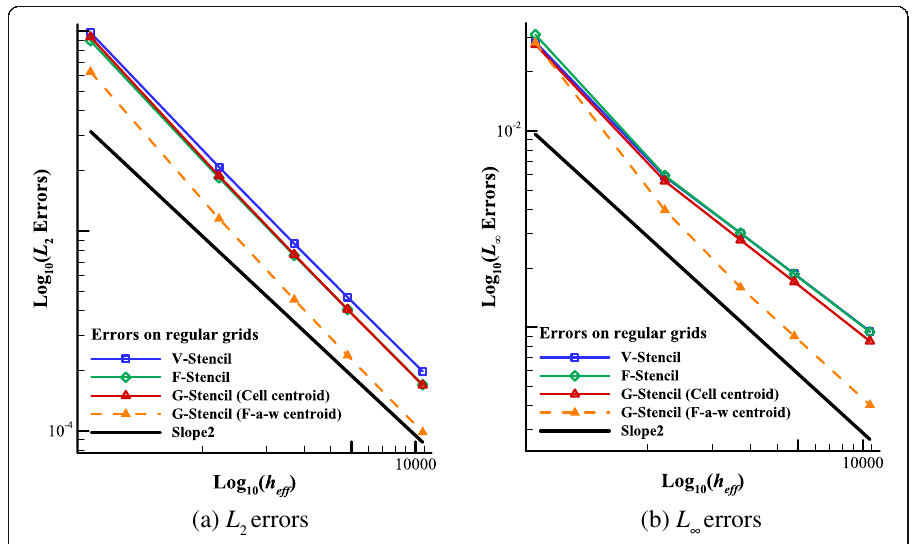
Fig. 14 ( a ) L 2 and ( b ) L ∞ errors. Errors of different stencils on regular grids with AR = 10